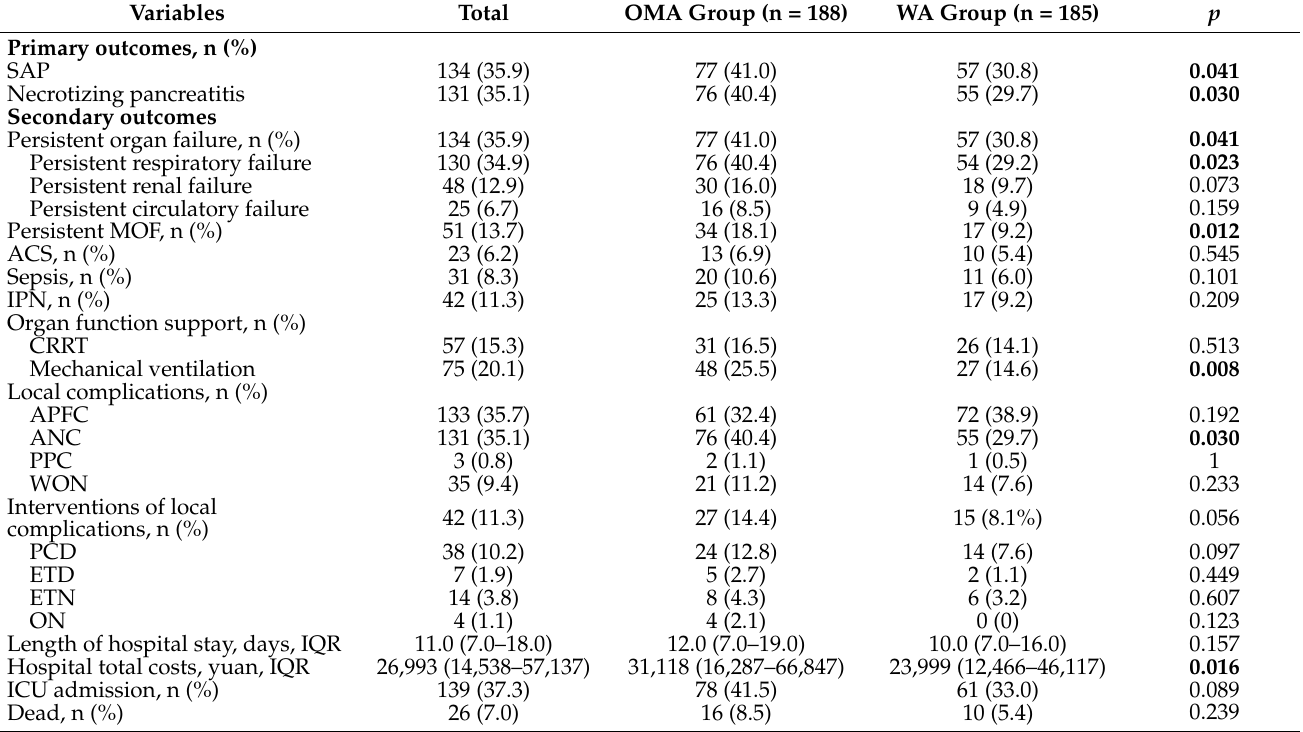
Table 3. Comparison of clinical outcomes in patients in OMA group and WA